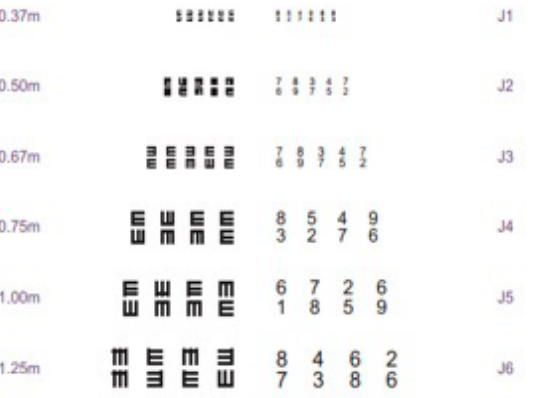
Figure 1. Jaeger’s Table for Measurement of Near Vision. (Source: Costa; Santos,